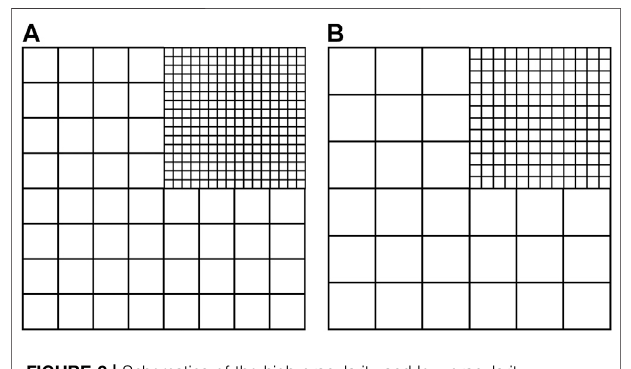
FIGURE 2 | Schematics of the high-granularity and low-granularity regions of the (A) electromagnetic and (B) hadron layers.